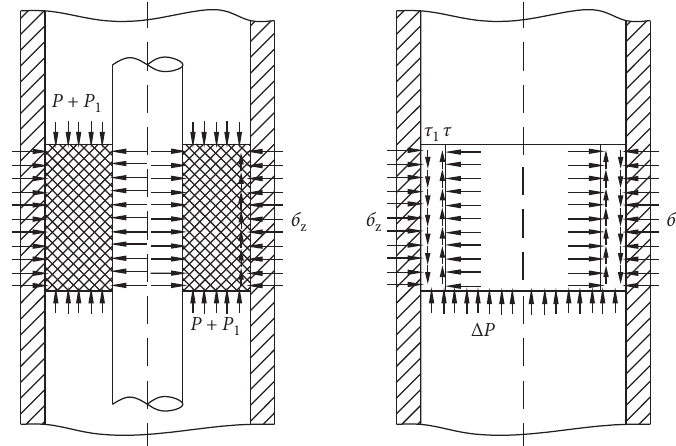
Figure 5: Shear effect diagram after sealing of the rubber cylinder. Table 1: Height of the rubber cylinder under different permissible shear stress and friction coefficients ( f ).